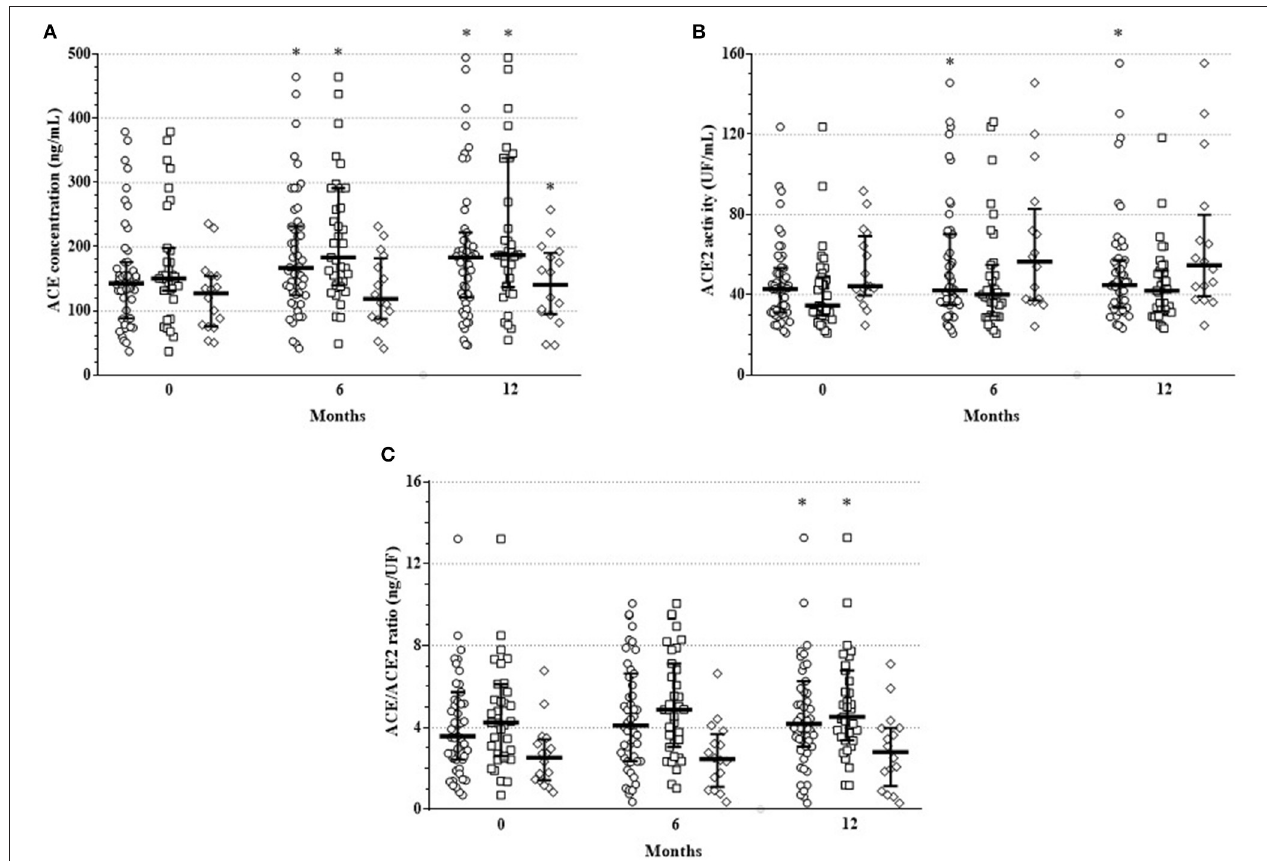
FIGURE 1 | One-year changes of (A) ACE concentration, (B) ACE2 activity and (C) ACE/ACE2 ratio upon TNF inhibition in the full RA + AS cohort (cycle symbol), as well as in the RA (square symbol) and AS subsets (diamond symbol). Median and interquartile range are shown on the figure; each symbol corresponds to an individual value. *indicate significant differences compared to baseline using Wilcoxon matched-pairs signed rank tests ( p < 0.05).